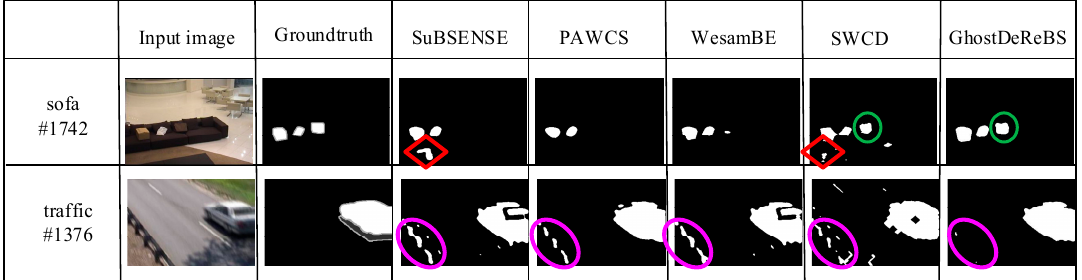
Figure 2. Comparison of the detection results among five methods.